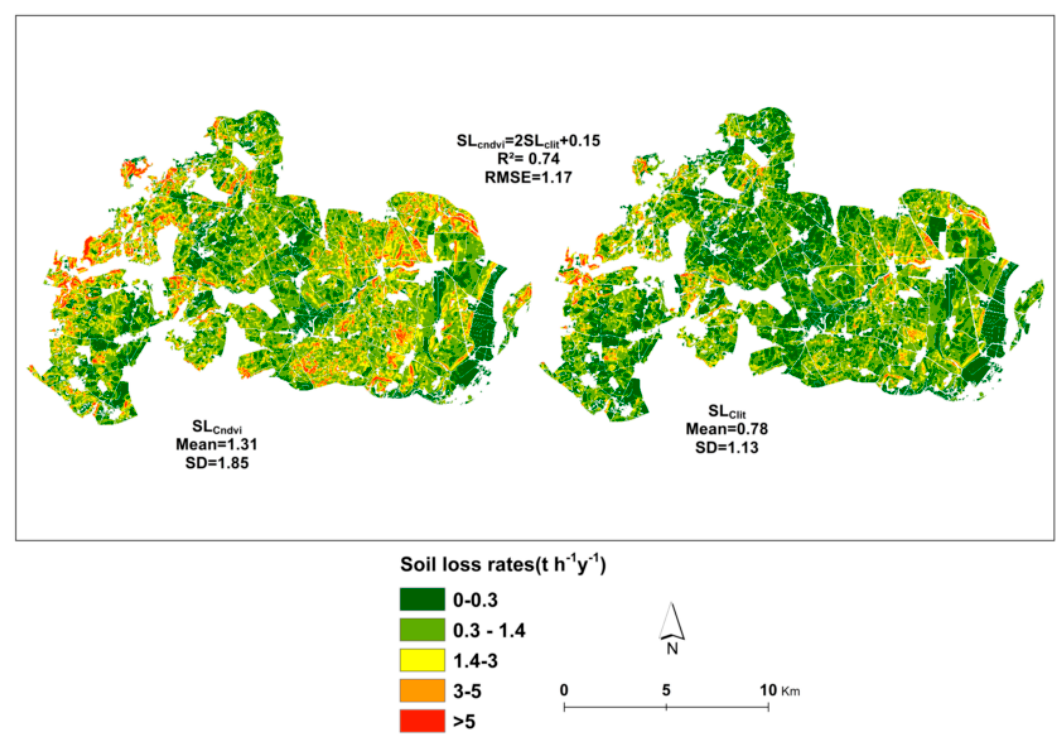
Figure 6. Spatial distribution of the predicted average annual potential soil loss rates using C ndvi (SL cndvi ) and C lit (SL clit ) values as inputs in the USLE model.